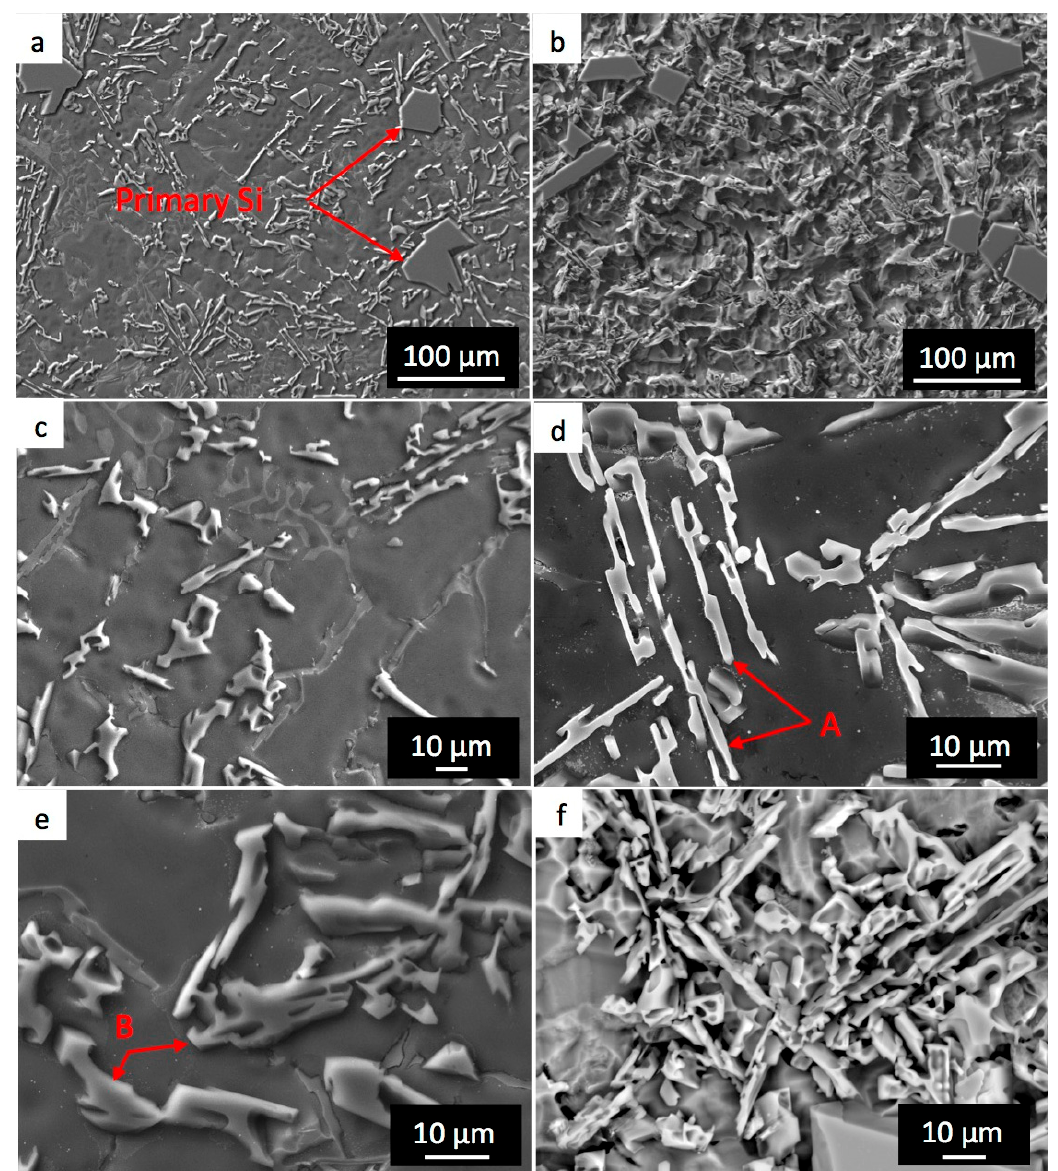
Figure 2. Solidification microstructure of the conventionally cast Al-18%Si-2%Cu alloy in ( a,b ) lower and ( c–f ) higher magnification: ( a,c–e ) conventional etching; ( b,f ) deep etching; A—needle-like particles of eutectic silicon; B—irregularly shaped coarse particles of eutectic silicon.